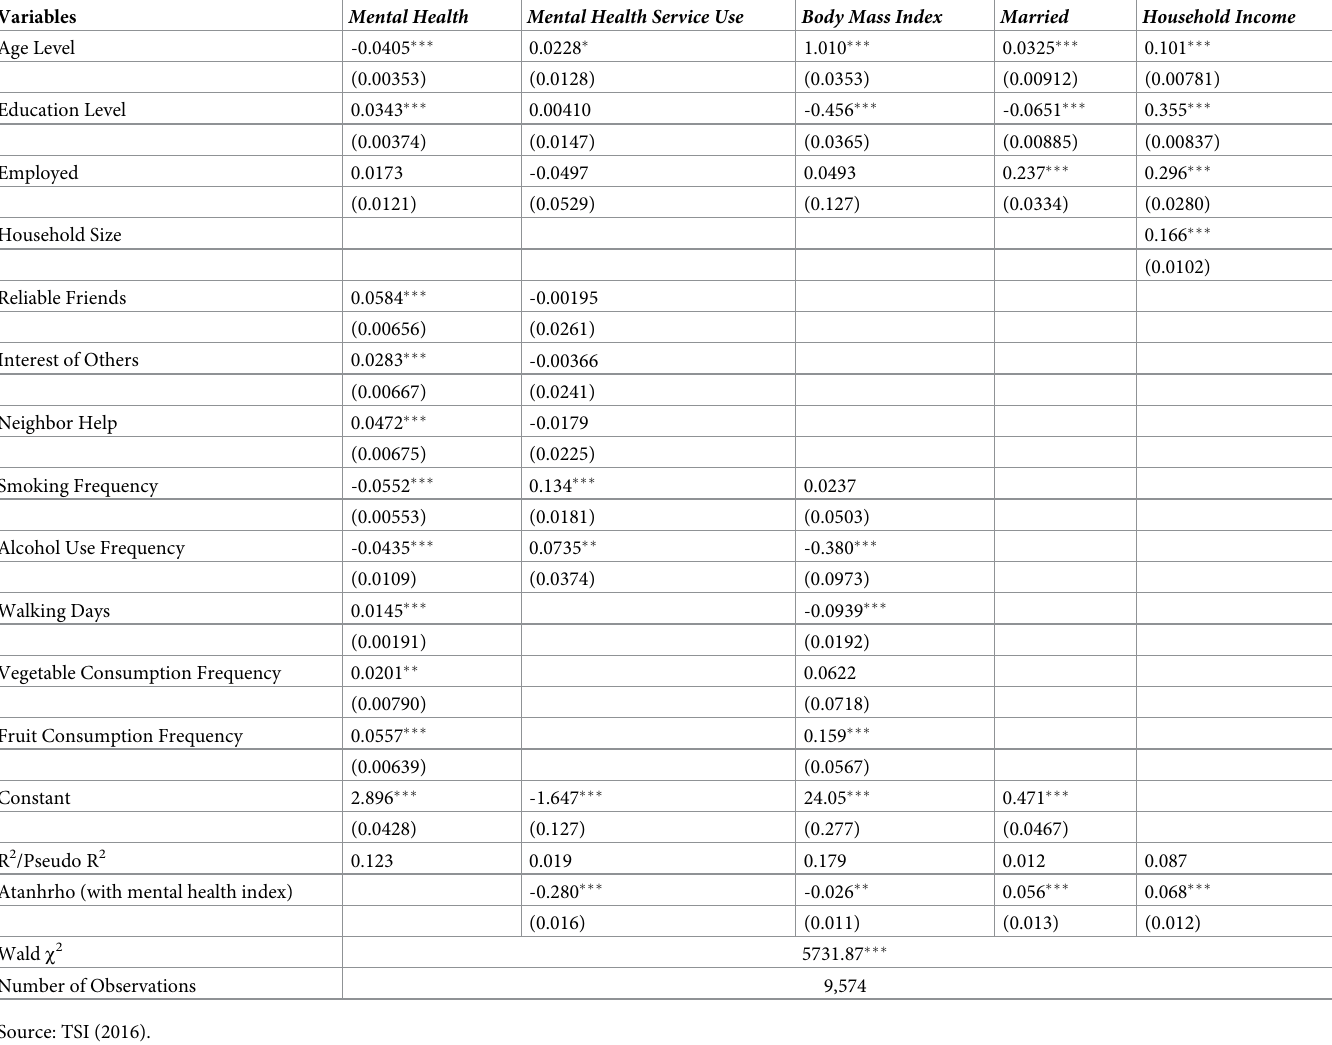
Table 5. CMP estimation results for mental health and income: Female